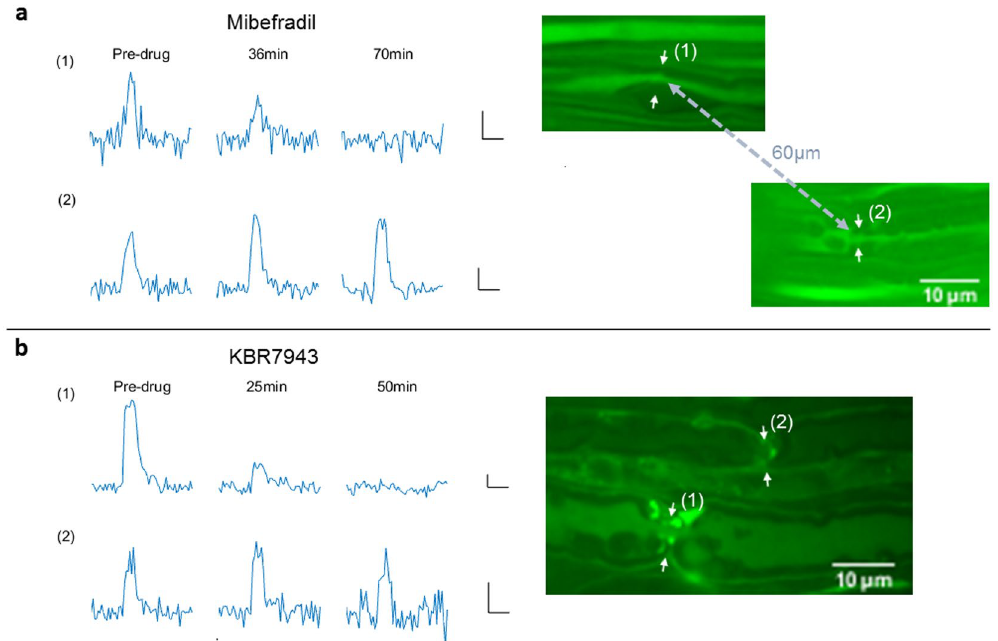
Figure 6. Nodes in close proximity show differential response to blockers. ( a ) Signals of two adjacent nodes in the same mibefradil-treated nerve sample show the blockage of signal in node (1) and the persistence of signal in node (2). ( b ) Two adjacent nodal signals in a KBR7943-treated nerve similarly shows a differential drug effect, with nodal signal (1) blocking and nodal signal (2) remaining unblocked. Single sweep recordings are shown. Inset scale bars are 1 s , and 3% dF/F o